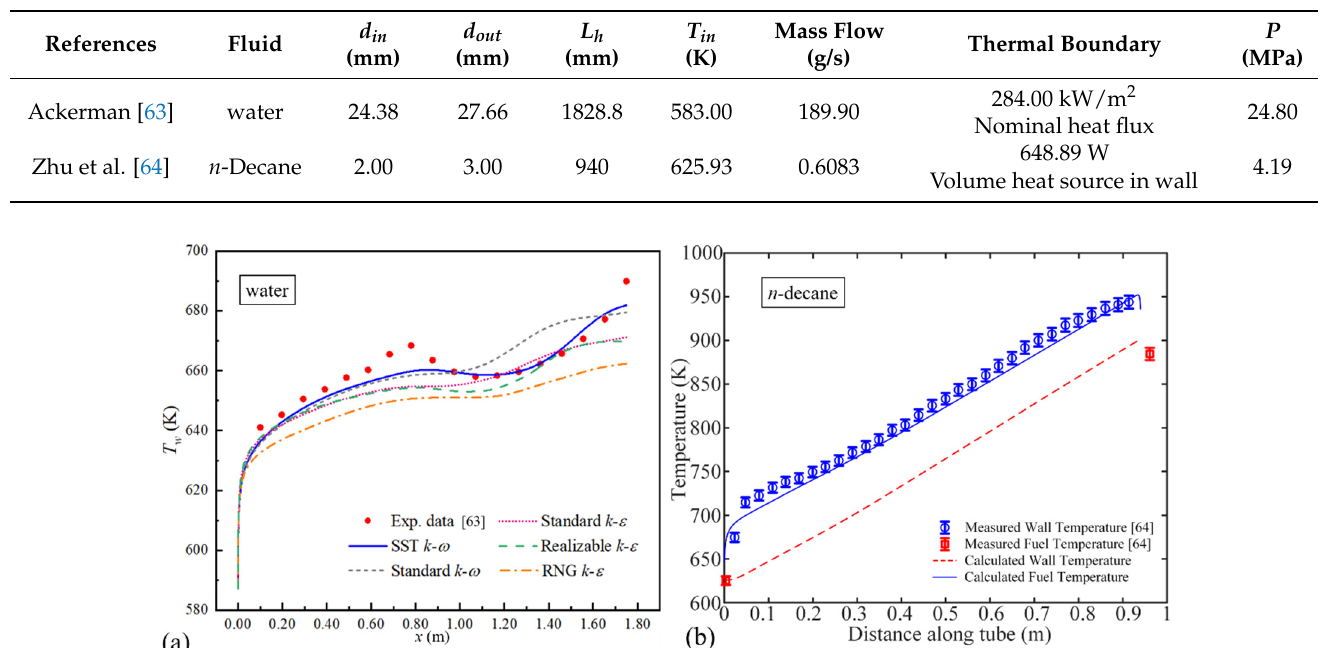
Table 1. Details of conditions chosen from the corresponding experimental research.